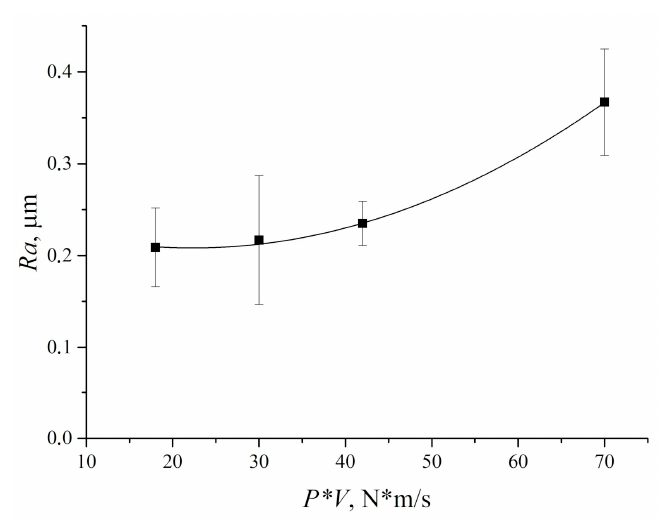
Figure 13. UHMWPE surface roughness vs. P · V tribological loading parameter.